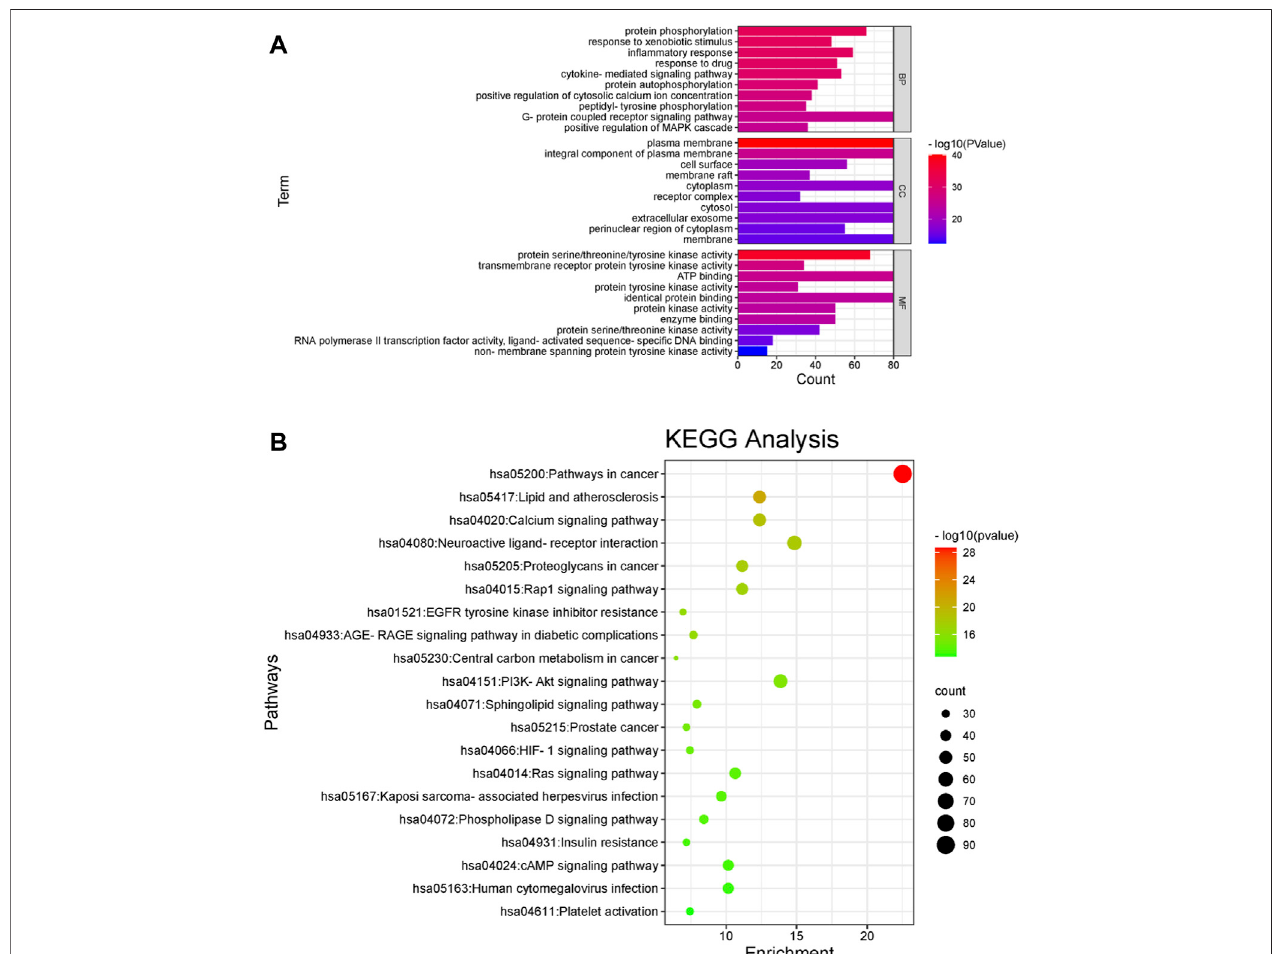
FIGURE 3 | GO analyses and KEGG pathway enrichment analyses of the gene symbols associated with sepsis. (A) GO analyses of the gene symbols associated with sepsis. The x -axis represents signi fi cant enrichment in the counts of these terms. The y -axis represents the categories in the GO of the target genes ( p < 0.05). The abscissarepresentsthenumberoftargets;theleftrepresentsBP,CCandMF;thecolorrepresents p -value;thesmallerthe p -value,theredderthecoloris;thelargerthe p -value,theblueritis. (B) KEGGpathway enrichment analyses ofthegenesymbols associatedwithsepsis.The x -axisrepresents thecountsofthetarget symbols in each pathway; the y -axis represents the main pathways ( p < 0.05). The abscissa represents the number of enriched genes, the left represents the name of pathway, and the color represents the p -value. The smaller the p -value, the more red the color is; the larger the p -value, the more green the color is.